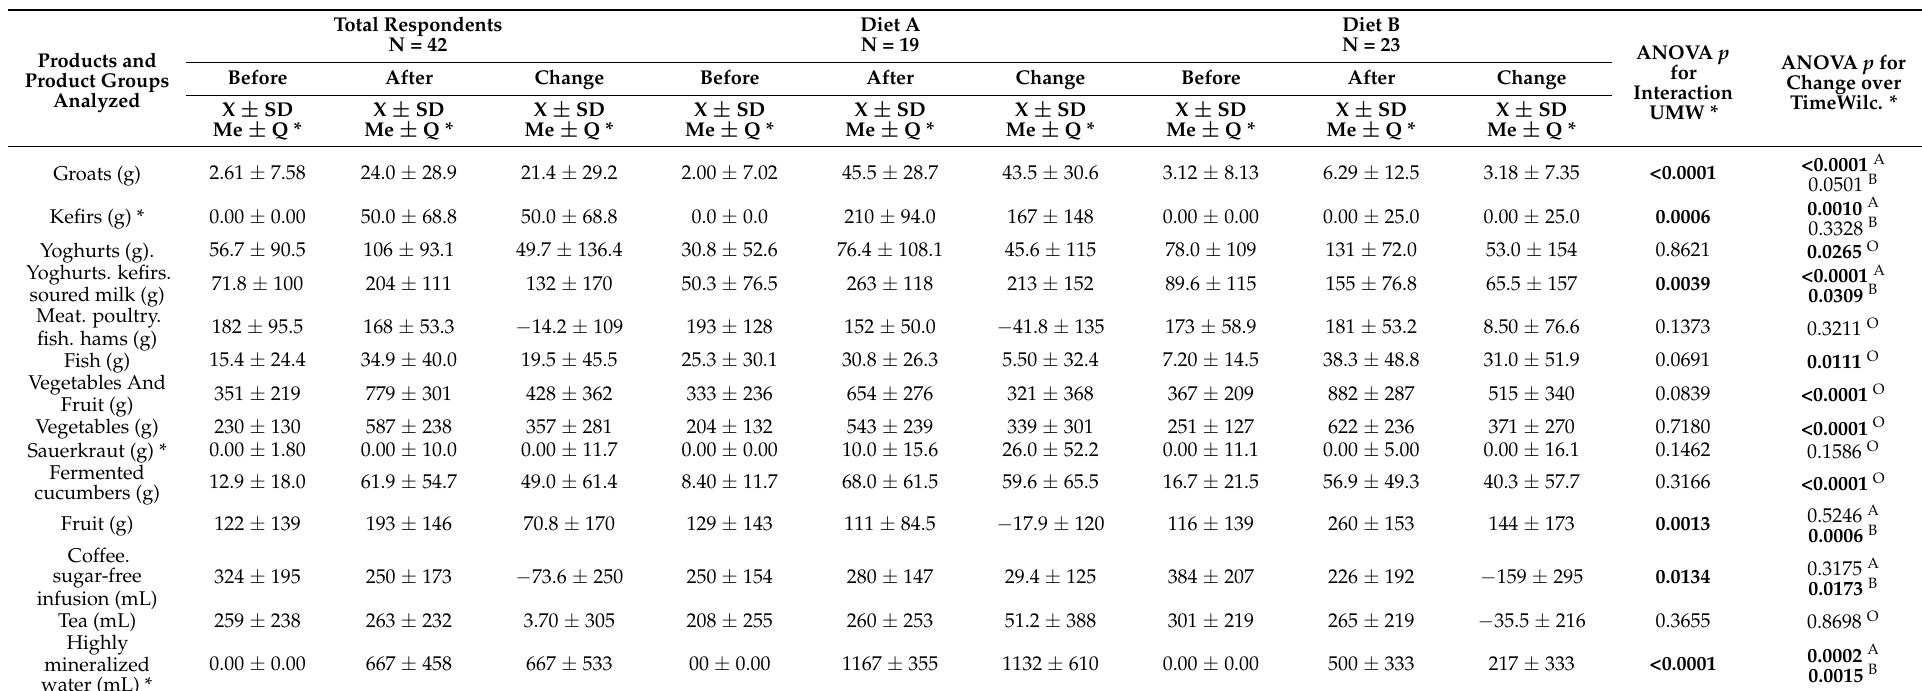
Table 2. Intake of selected food items by female study participants before and after 3 months of dietary